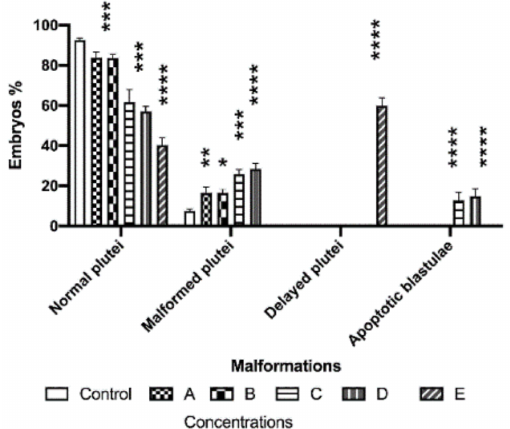
Figure 2. Percentage of normal plutei, malformed plutei, delayed plutei, and apoptotic blastulae produced by exposing newly fertilized eggs to five PAHs concentrations (A, 192, B, 19.2 × 10 2 , C, 19.2 × 10 3 , D, 19.2 × 10 4 , E, 19.2 × 10 5 µ g/L) in comparison with the control, represented by newly fertilized eggs in filtered sea water. Data are reported as mean ± standard deviation. The statistical significance of differences between test groups and controls is reported as follows: * p < 0.05, ** p < 0.01, *** p < 0.001, **** p <